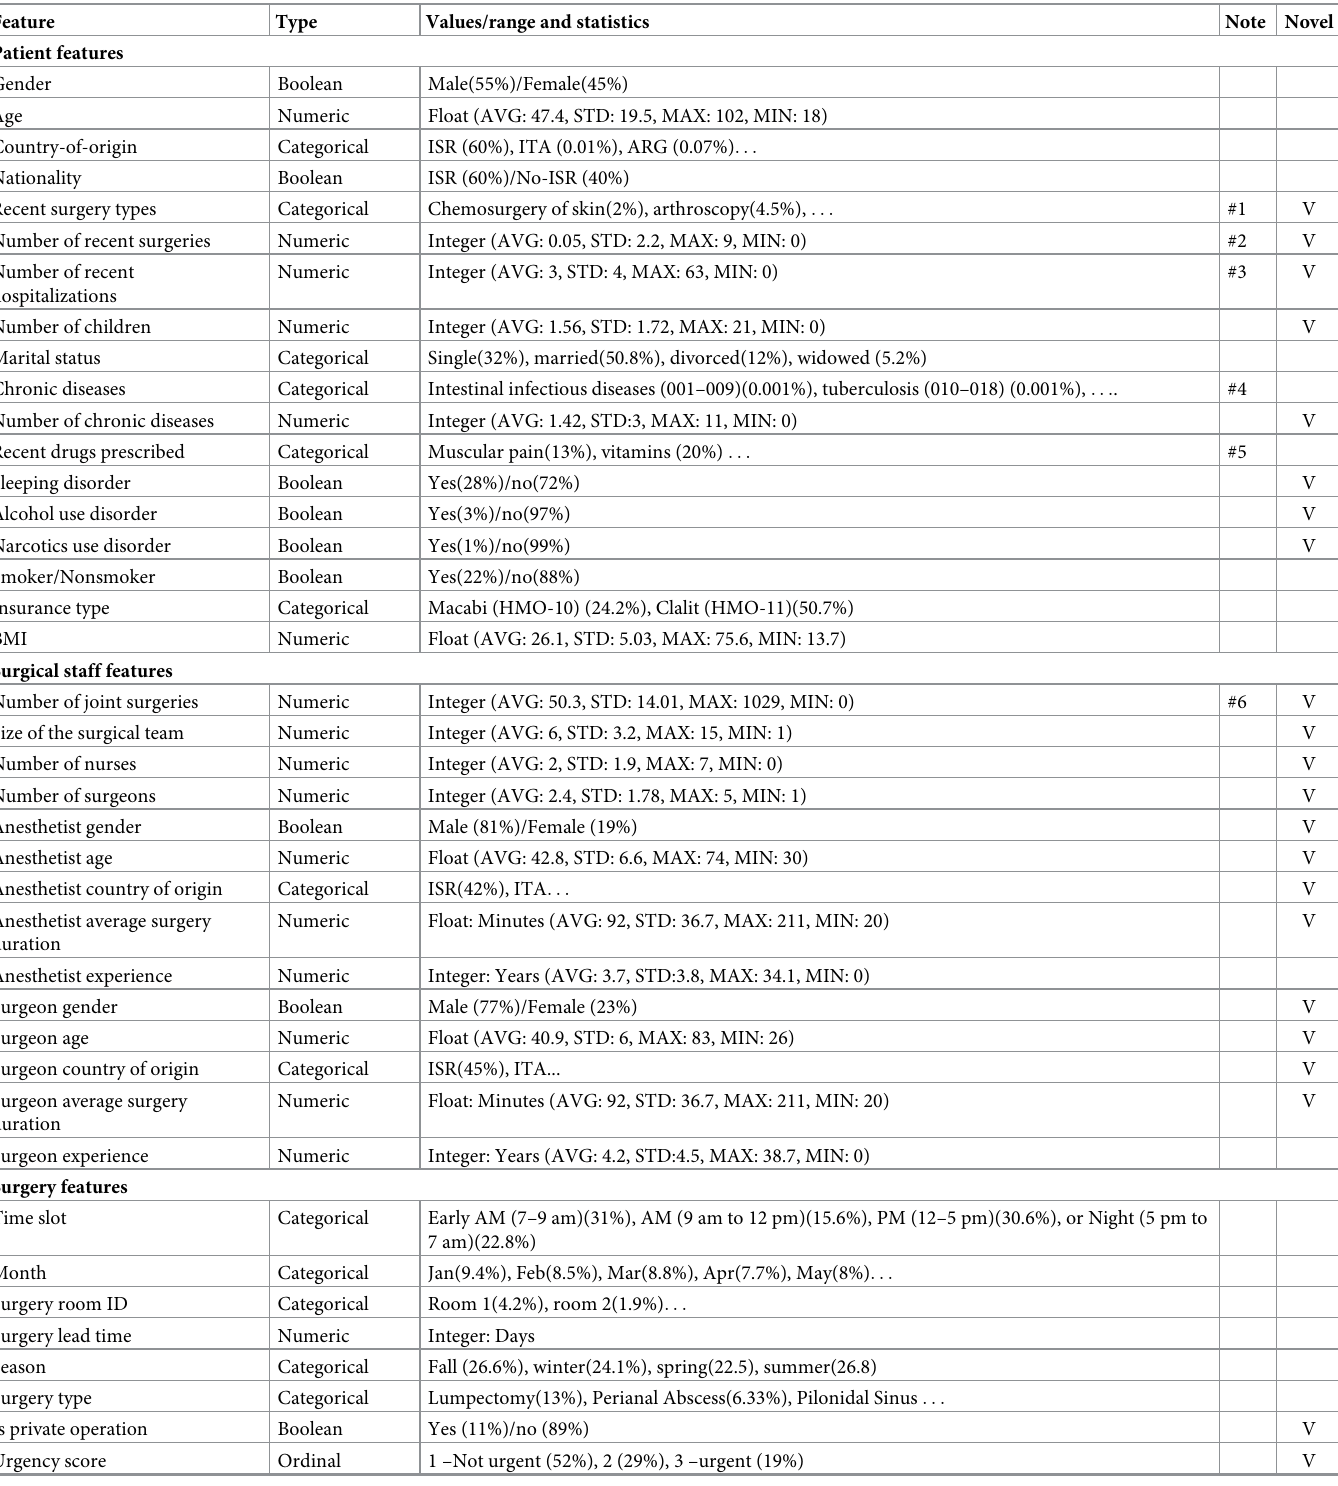
Table 1. Description of